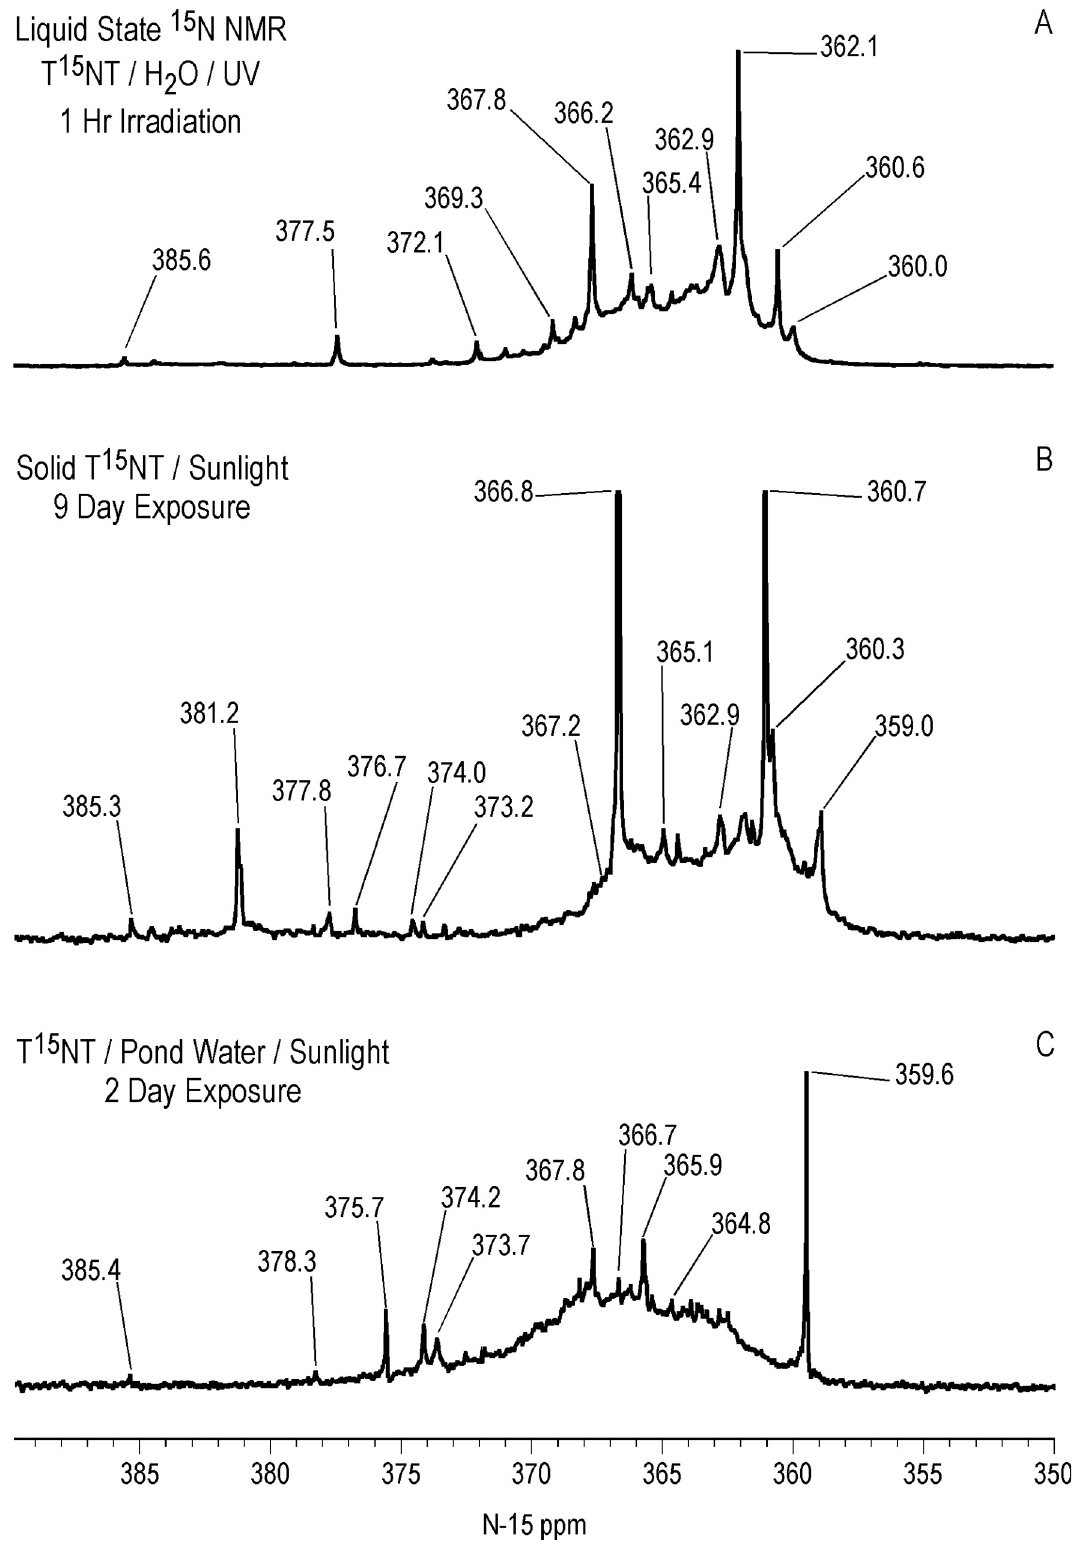
Fig 15. Liquid state N-15 NMR spectra of nitro region of irradiated T 15 NT. Line broadening = 1.0 Hz. A. 1 hour lamp irradiation in deionized water, IGD spectrum. B. 9 day sunlight irradiation in the solid state, ACOUSTIC spectrum. C. 2 day sunlight irradiation in pond water, IGD